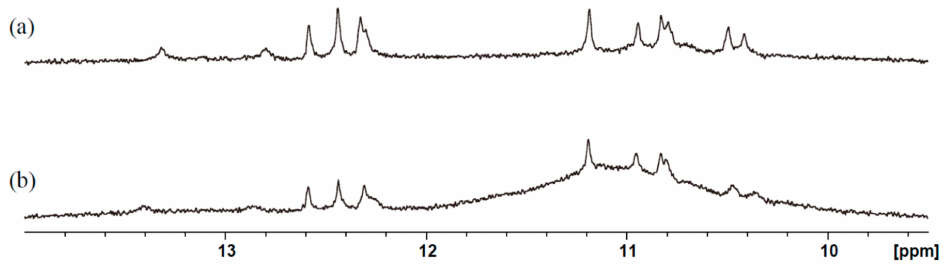
Figure 6. Imino proton regions of 1 H-NMR spectra of 50 µ M MYC alone ( a ) or with 100 µ M calmyc ( b